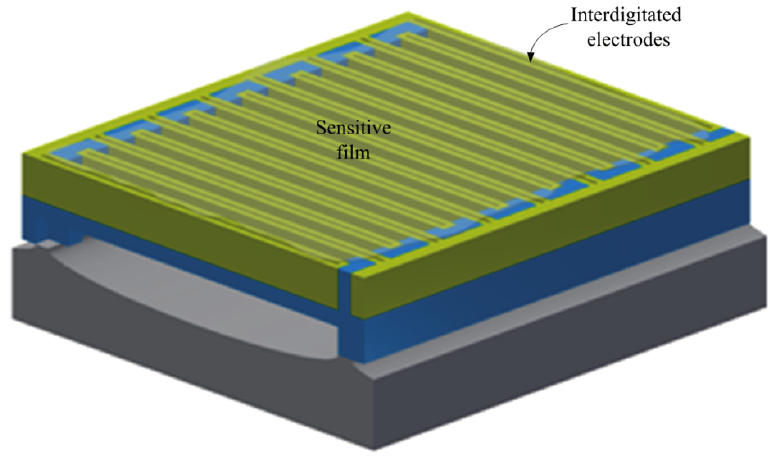
Figure 1. Schematic structure of the methanol